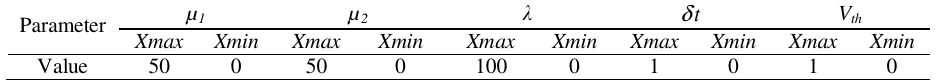
Table 3. Maximum and minimum values of the parameters.